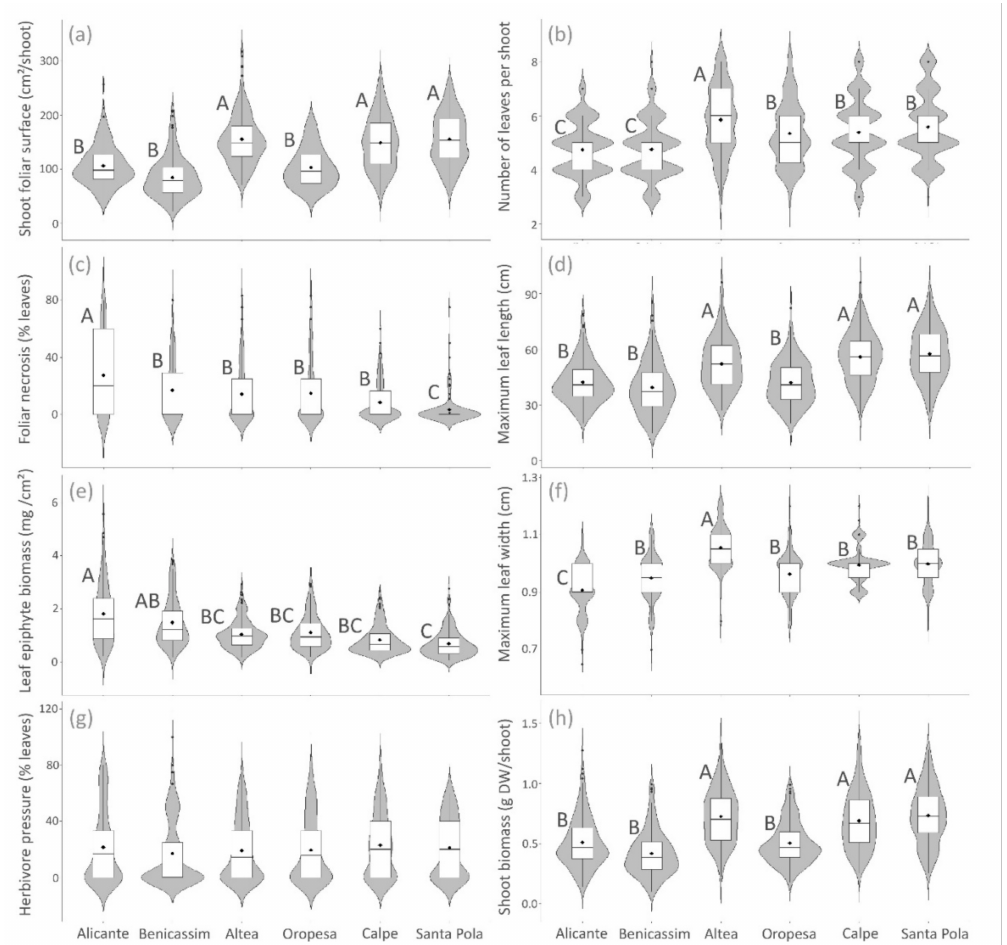
Figure 3. Violin plots for Posidonia shoot morphological descriptors at each of the six locations, including: ( a ) Shoot foliar surface, ( b ) Number of leaves per shoot, ( c ) Foliar necrosis, ( d ) Maximum leaf length, ( e ) Leaf epiphyte biomass, ( f ) Maximum leaf width, ( g ) Herbivore pressure, and ( h ) Shoot biomass. Boxplots denote the first and third quartile, the minimum and maximum values are represented as the lower and upper part of the whiskers, the median is symbolized by a black horizontal line, and the mean by a black diamond. Outliers are represented as dot points. Di ff erent capital letters are statistically di ff erent at p <